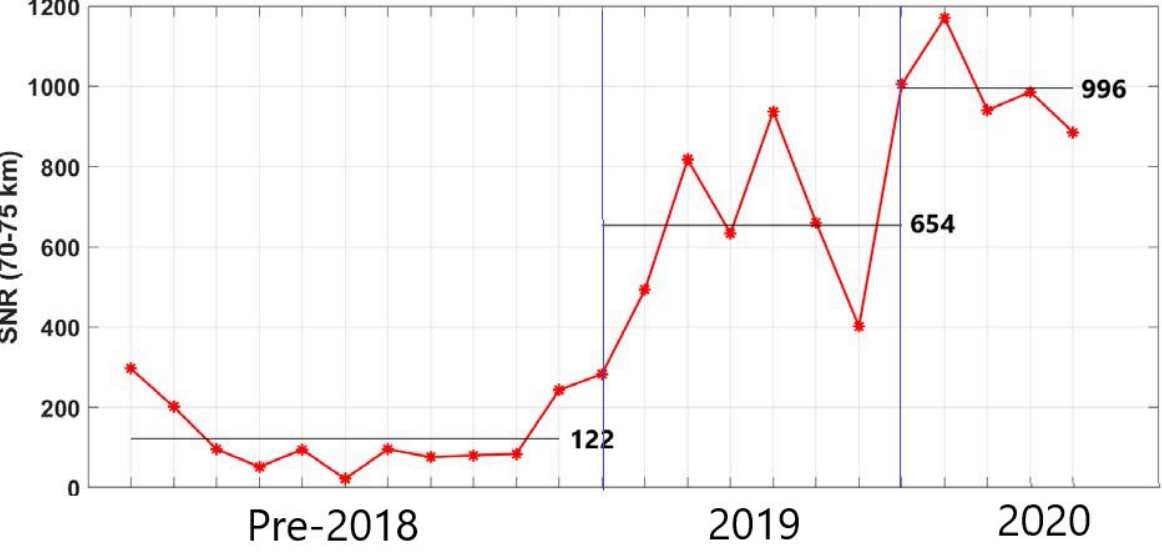
Figure 1. Monge lidar SNR from 70 to 75 km for selected nights. The improvements in 2019 correspond to the replacement of the PMTs and Licel; the improvements in 2020 correspond to the replacement of all nine lidar